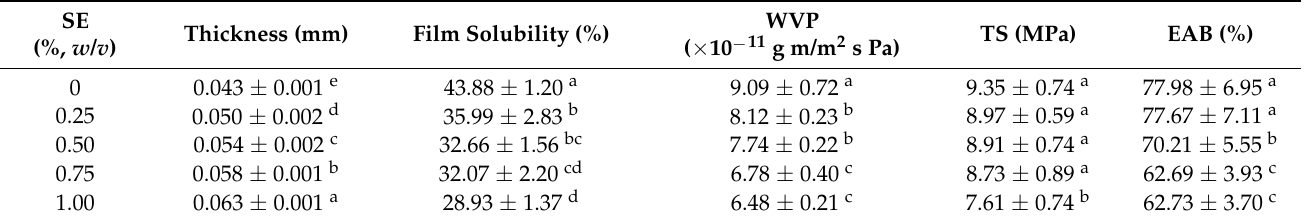
Table 1. Thickness, film solubility, WVP, and mechanical properties of gelatin films incorporated with sappan heartwood extract (SE) at different